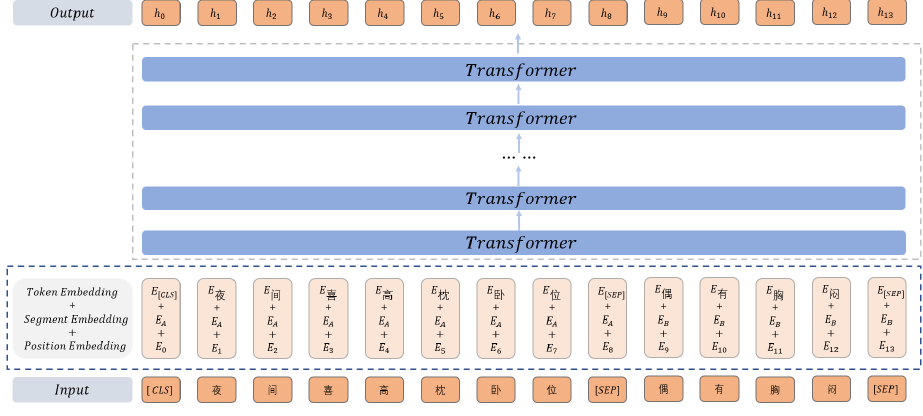
Figure 2. Structure diagram of RoBerta.